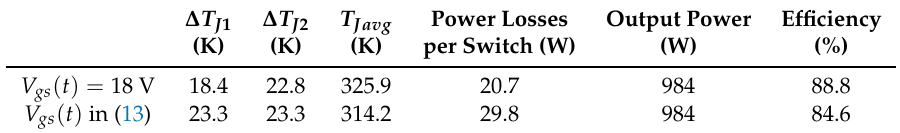
Table 6. Performance evaluation at low speed operation with 10 kHz switching